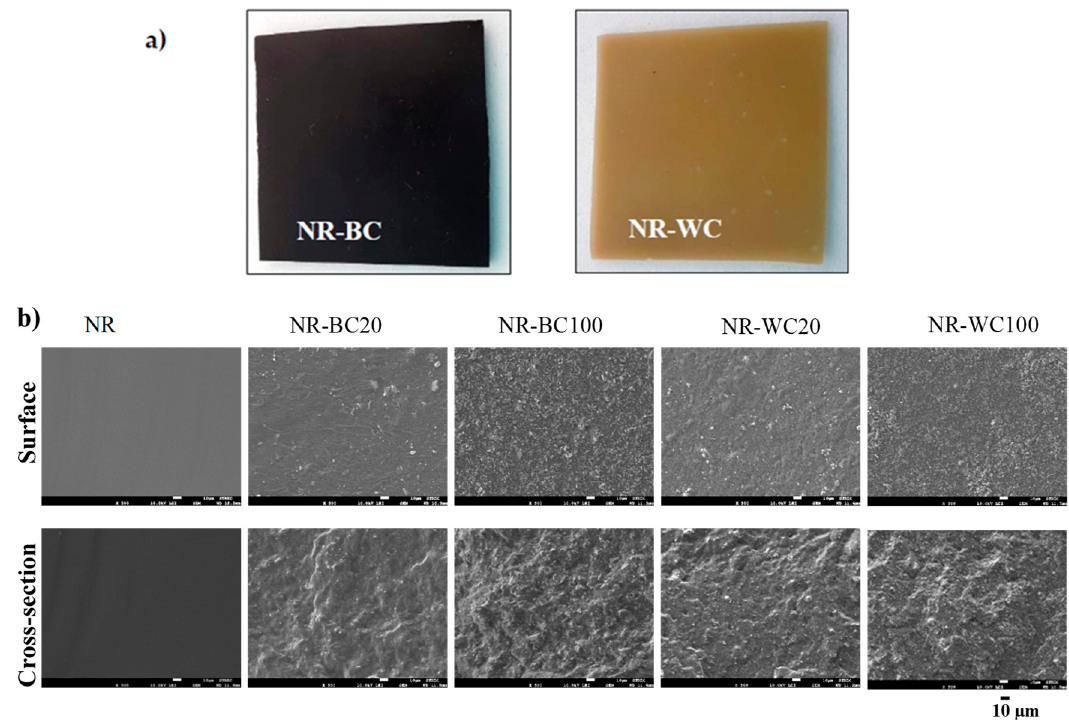
Figure 5. The outlook ( a ) and SEM micrographs ( b ) of surface morphologies (on the top) and cross-section (on the bottom) of NR, NR–BC20, NR–BC100, NR–WC20 and NR–WC100.